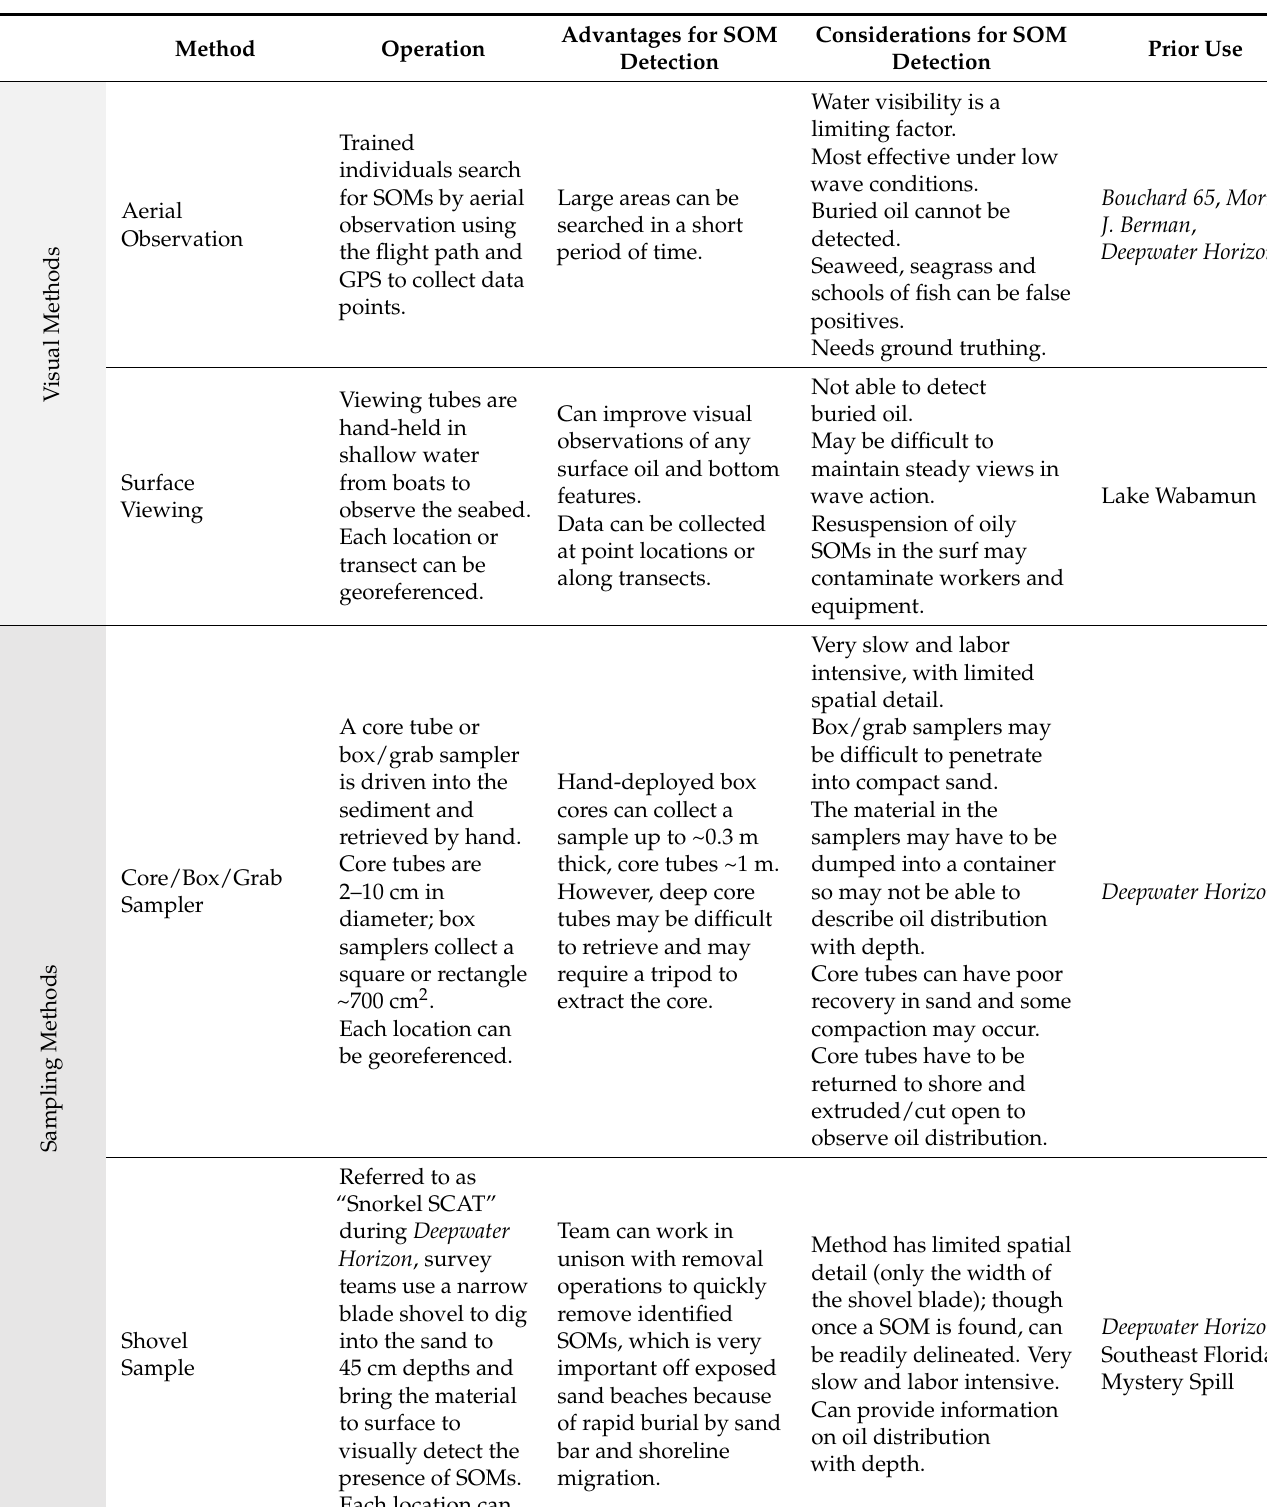
Table 5. SOMs detection methods in the surf